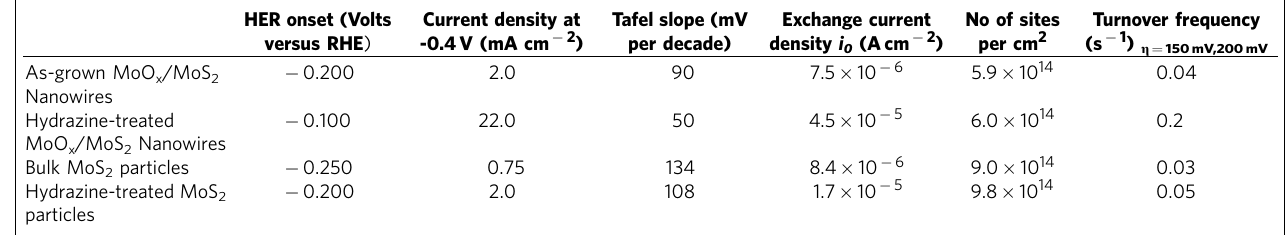
Table 1 | Electrochemical parameters with hydrazine treatment of MoS 2